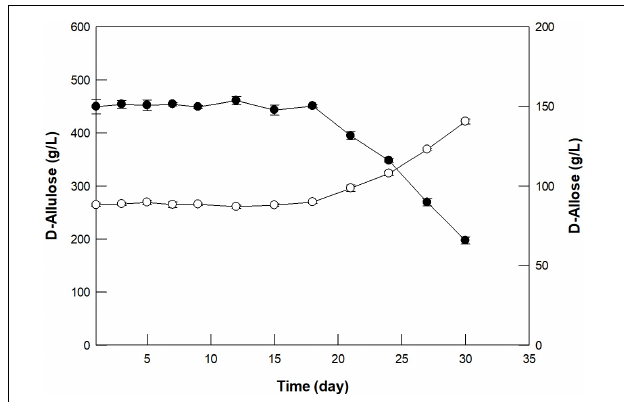
FIGURE 5 | Continuous production of D -allose (closed circles) from D -allulose (open circles) using immobilized GI in a packed bed reactor. A solution of 50 mM EPPS buffer (pH 8.0) containing 500 g/L D -allulose was fed continuously into the reactor, and the effluent was allowed to flow out of the reactor at a dilution rate of 0.24/h. The reaction was performed at 60 ◦ C for 30 days. Data represent the means of three experiments ±